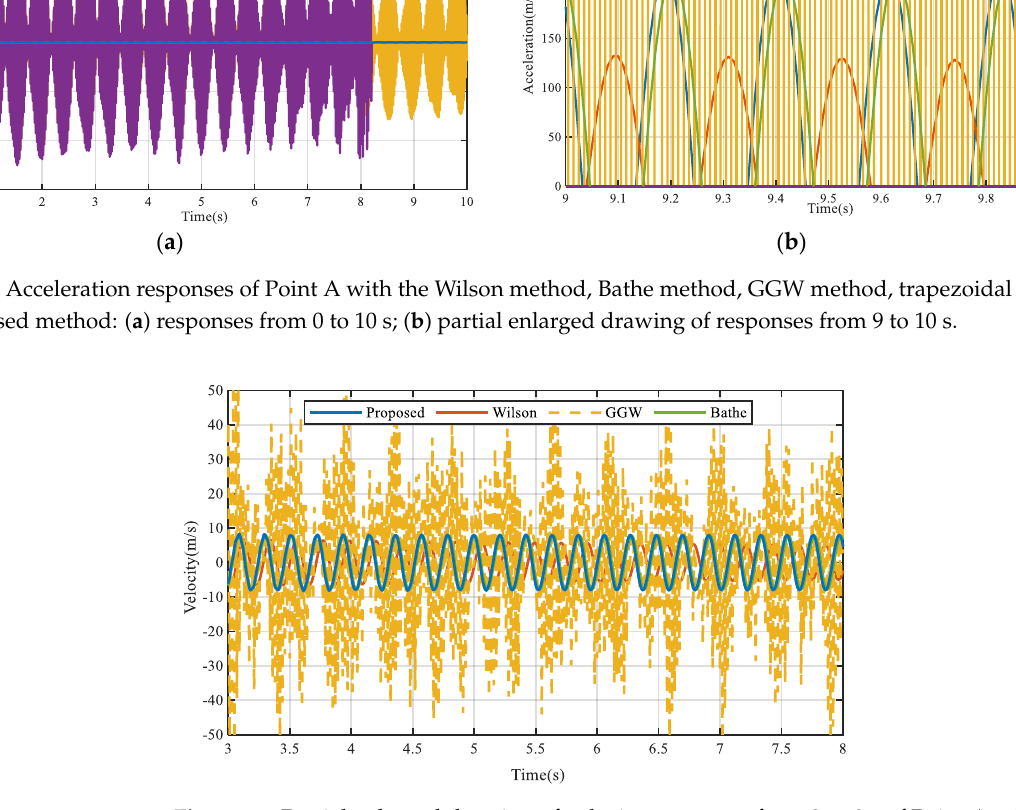
Figure 16. Partial enlarged drawing of velocity responses from 3 to 8 s of Point A with the Wilson method, Bathe method, GGW method, and the proposed method.